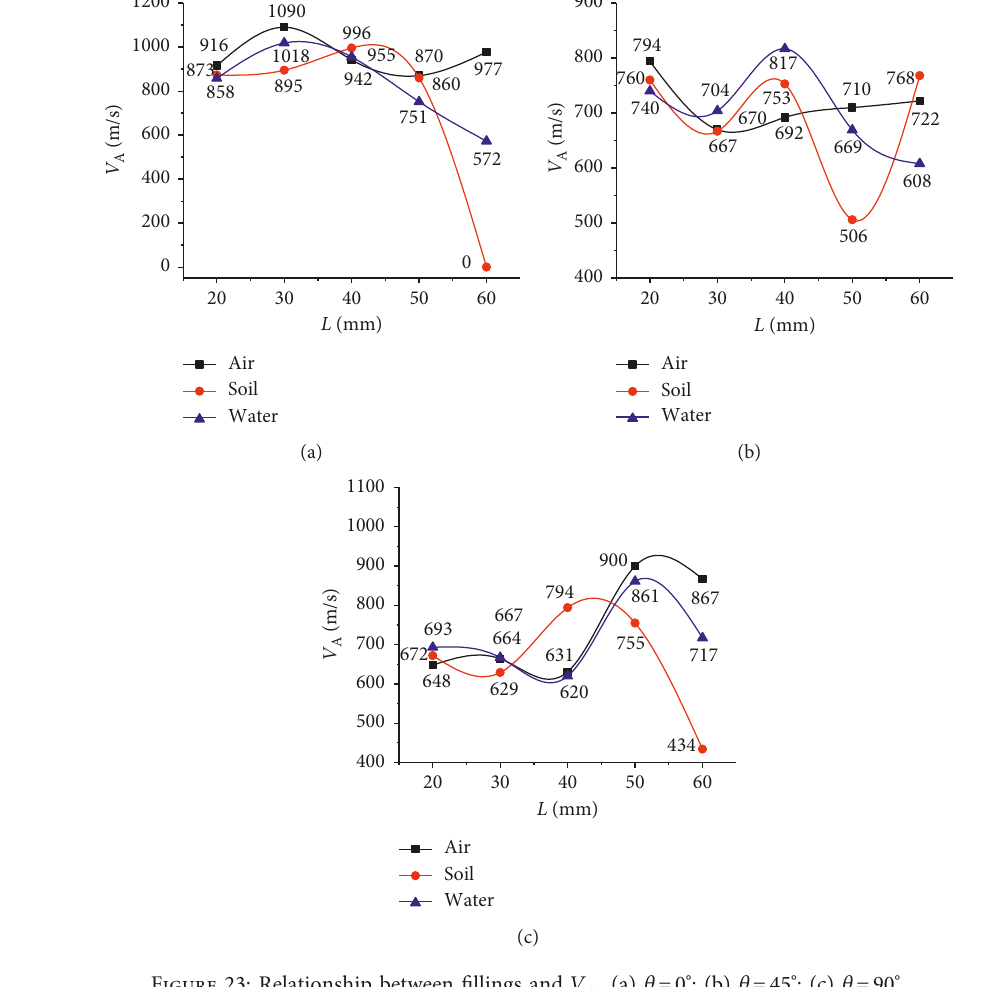
Figure 23: Relationship between fillings and V